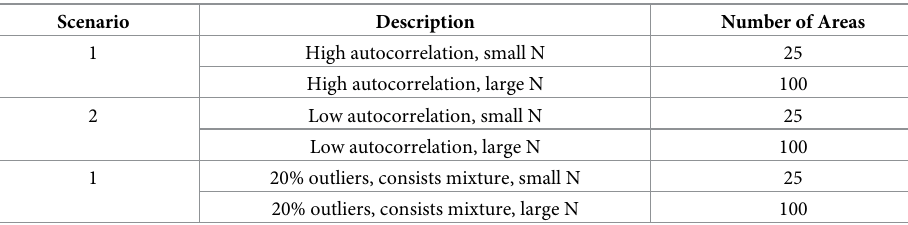
Table 3. Description of simulation scenarios for data